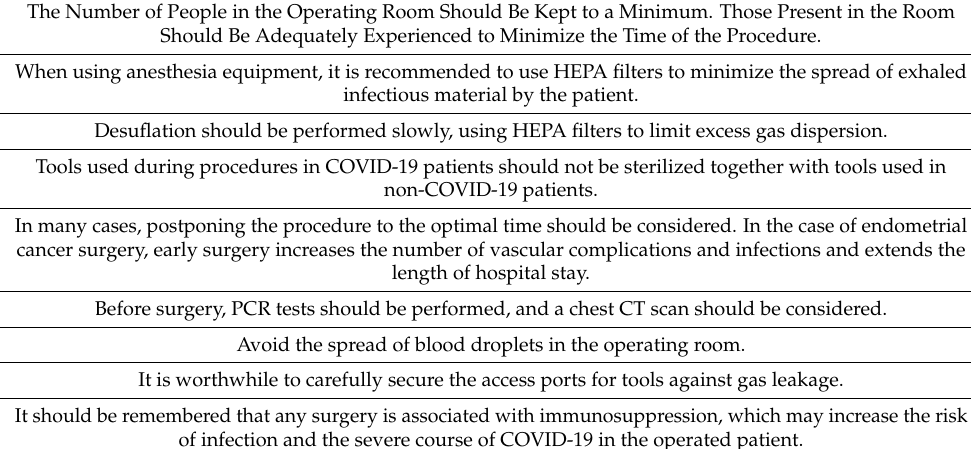
Table 1. Recommended procedures in laparoscopic surgery increasing the safety of medical personnel in the time of the COVID-19 pandemic [9].